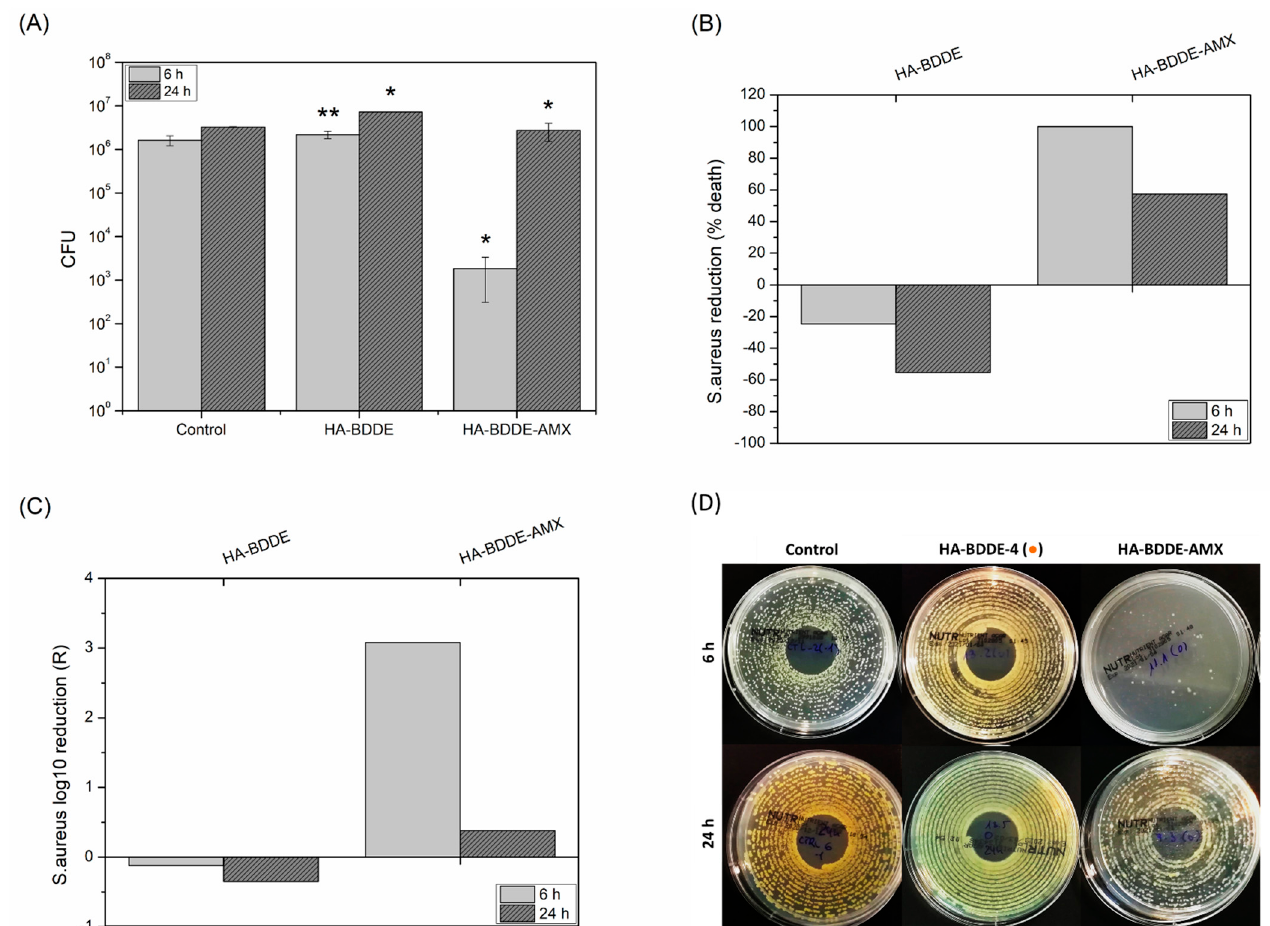
Figure 6. ( A ) Colony Forming Units, ( B ) bacterial reduction (% death), and ( C ) log10 reduction (R) for control, HA-BDDE-4, and HA-BDDE-AMX. ( D ) Images of S. aureus agar plates. * Significant differences ( p < 0.05), ** non-significant differences ( p > 0.05).